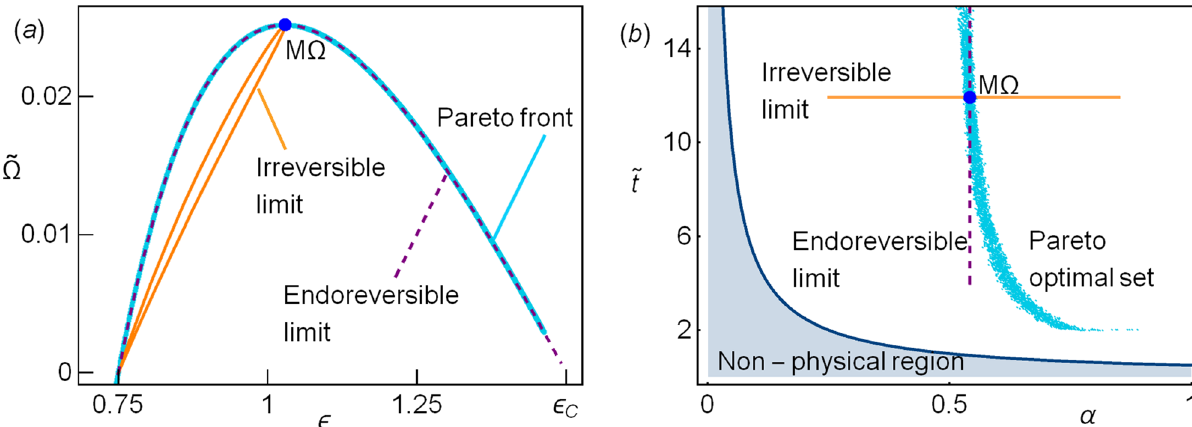
Figure 1. ( a ) The Pareto front (cyan points) matches the endoreversible limit (parabolic dashed line). For completeness, the irreversible limit is also depicted (loop-like curve). ( b ) The Pareto optimal set is shown (cyan points). The constraints α representative values τ